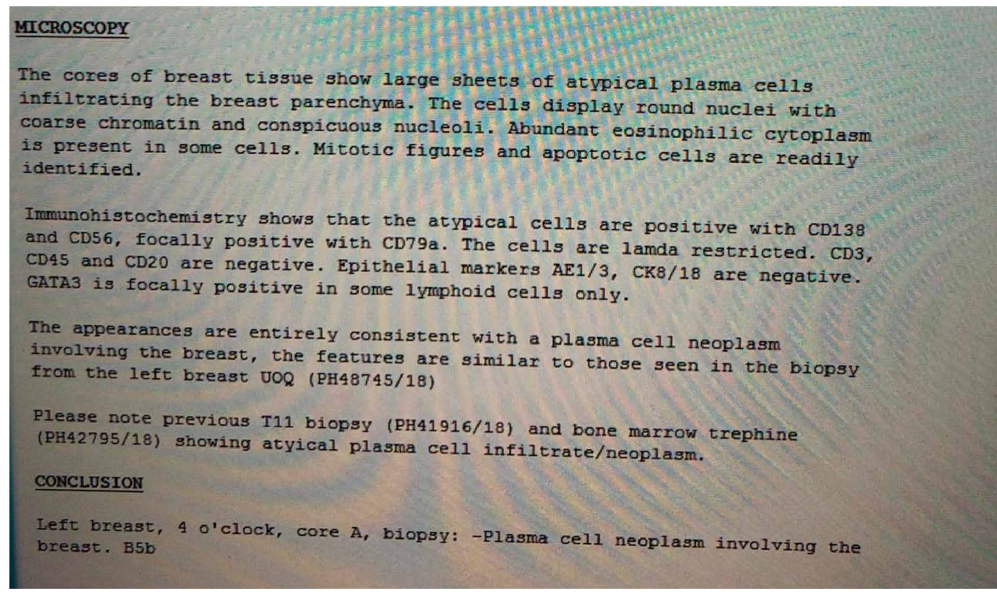
Figure 9: Pathology